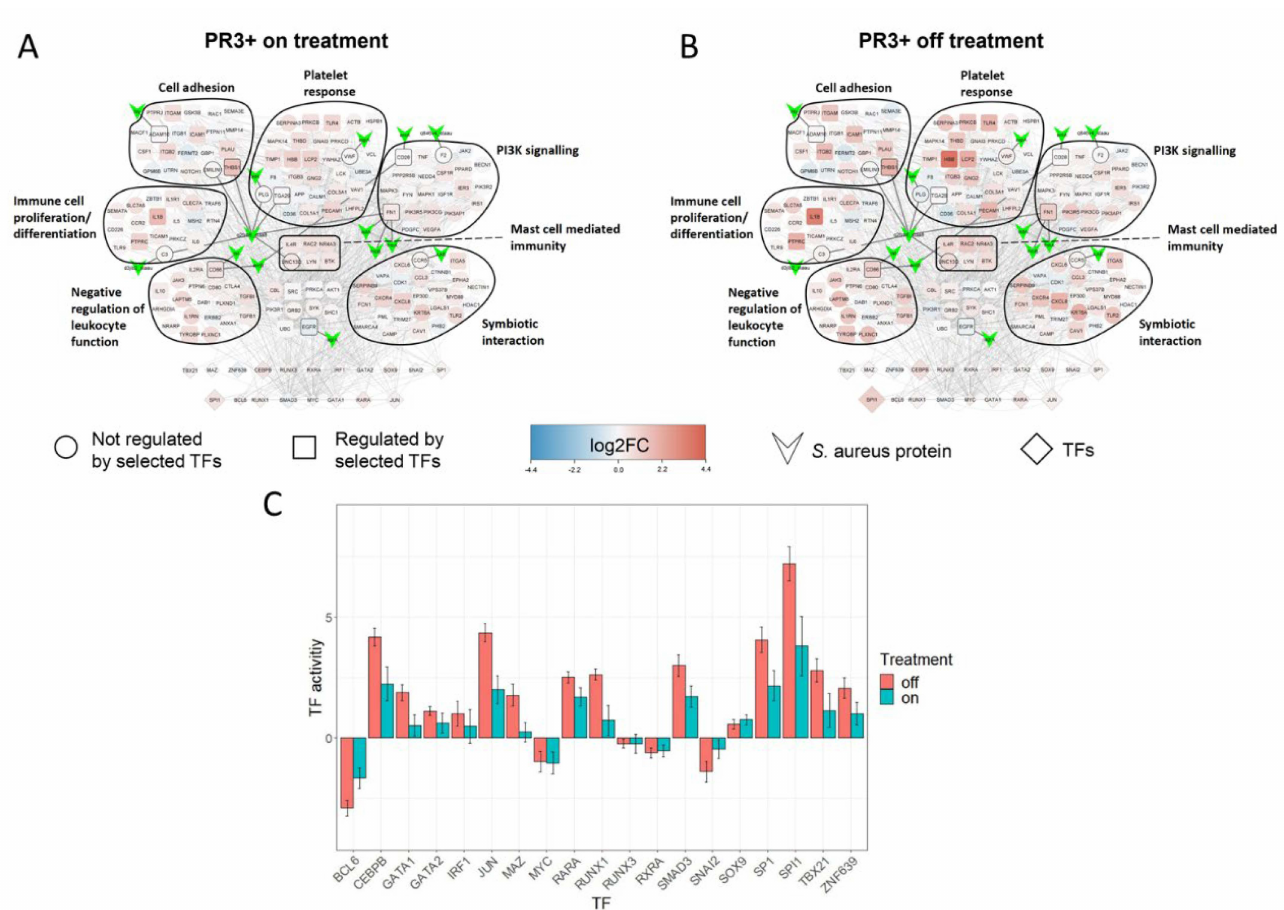
Figure 4. Comparison of SA-PR3+ AAV interaction networks between on and off treatment groups (excluding prednisone). ( A , B ) SA-PR3+ AAV interaction networks with nodes representing different classes of genes (as specified in the key) and edges representing protein–protein interactions (PPIs). The size of each TF was mapped to their estimated activity. Reduced differential expression and TF activity observed in those treated by immunosuppressants. ( C ) Bar chart showing average TF activity in on/off treatment groups. The bars were coloured green/red representing patients on/off treatment. Error bars show the standard error of the